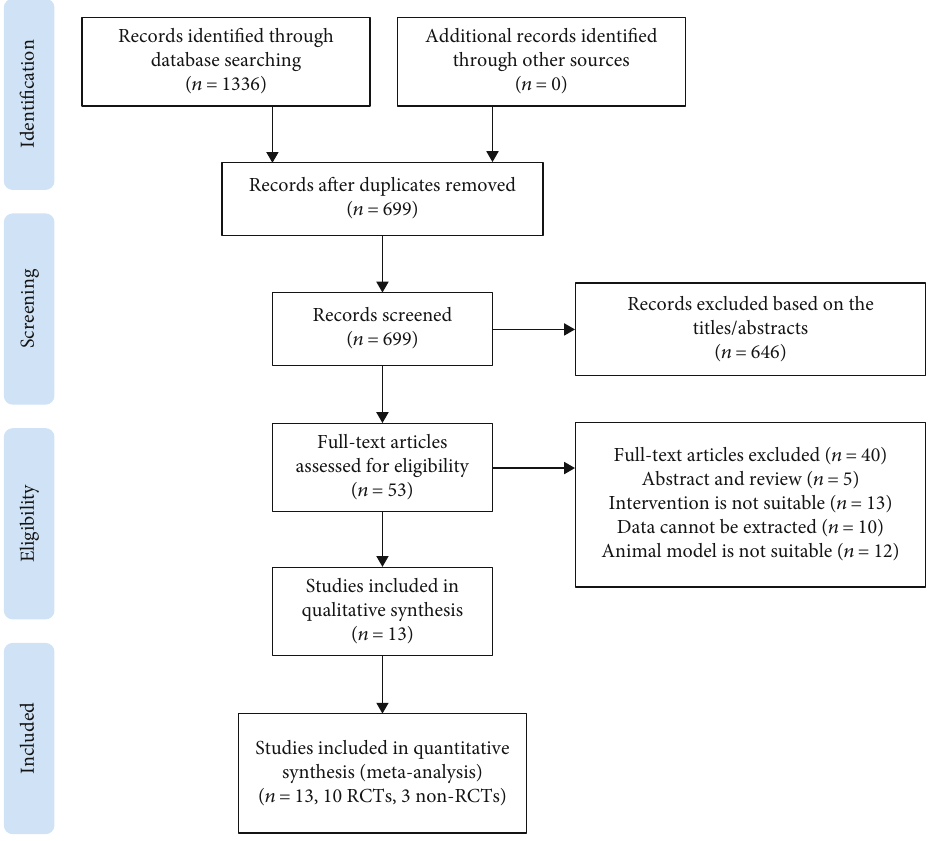
Figure 1: Flow chart of literature search and screening for